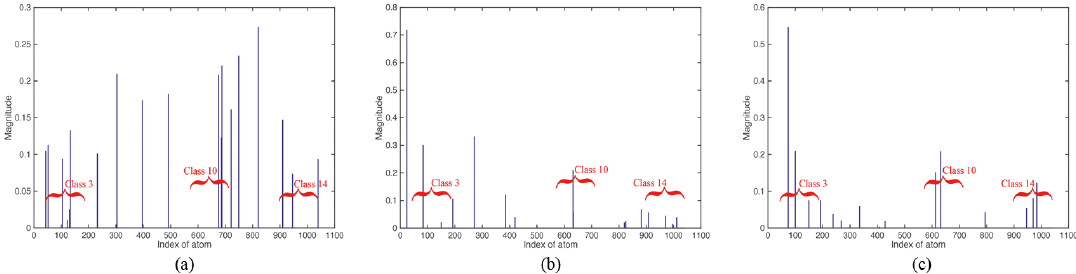
Figure 8. Estimated sparse coefficients (spectral space) for one pixel (belonging to Class 3) in the Indian Pines image. ( a ) Spectral space; ( b ) extended morphological attribute profile (EMAP) space; ( c ) deep feature